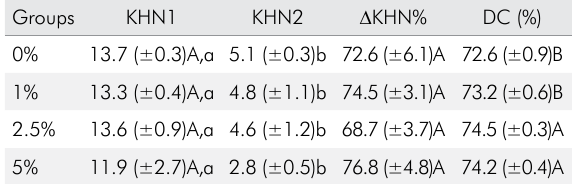
Table. Microhardness values before (KHN1) and after immersion in solvent (KHN2) and the variation of microhardness values ( Δ %). Mean (+- standard deviation) degree of conversion (DC).